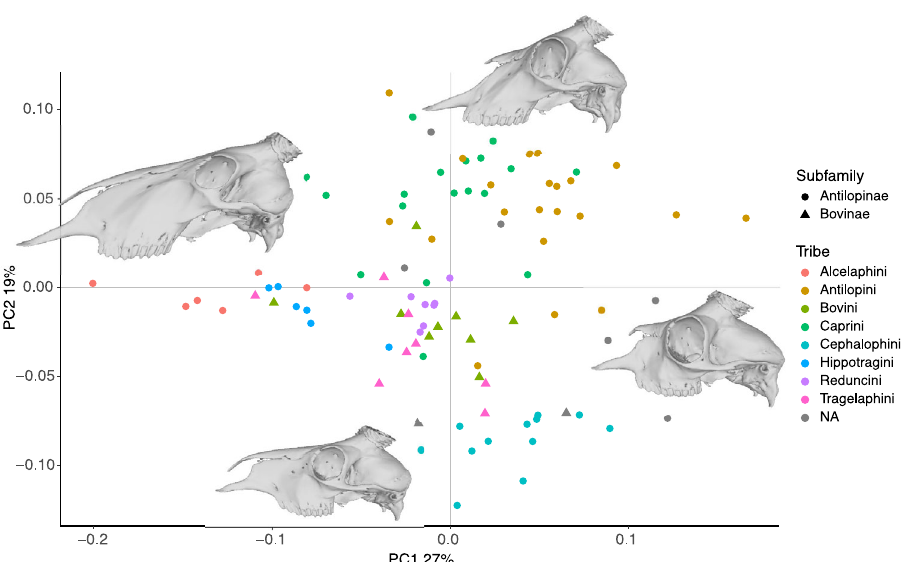
Fig. 2 First two principal components of the analysis of 96 crania representing 96 species. In lateral view, PC1 captures mainly facial elongation and both PC1 and PC2 capture aspects of facial depth and nasal retraction. Reconstructions were made by warping a cranium of Naemorhedus goral (AMNH 43033) to extreme PC values. See Supplementary Fig. 4 for a version with species